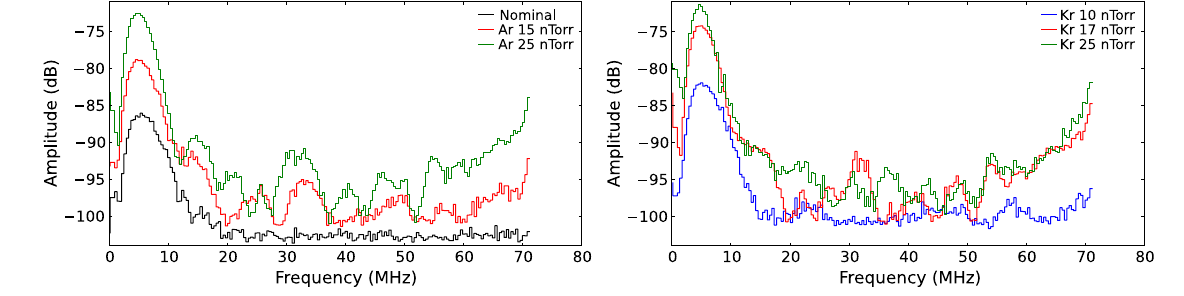
FIG. 5. Vertical lower sideband spectra at different pressures.